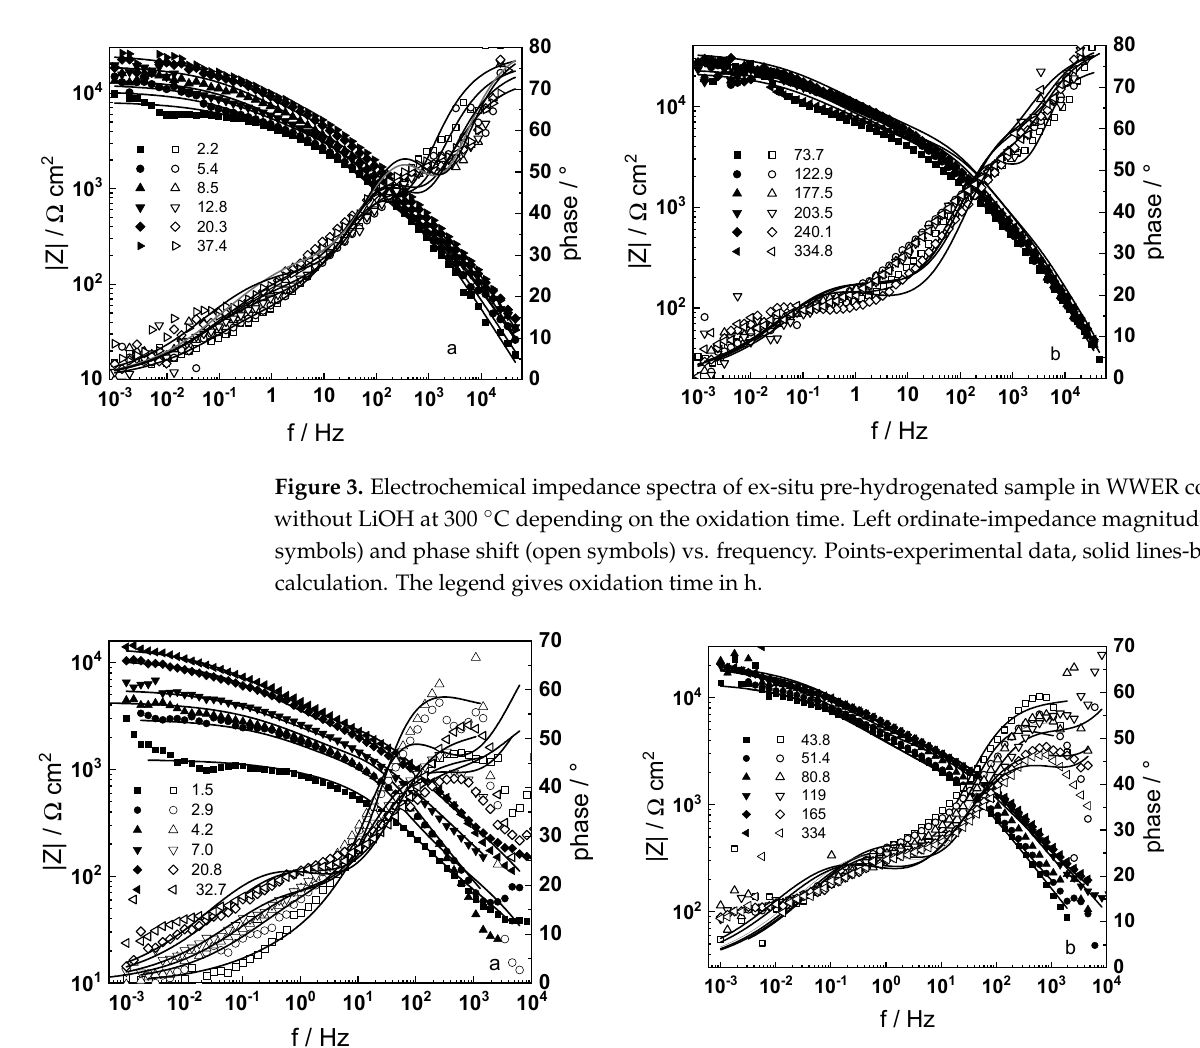
Figure 4. Electrochemical impedance spectra of in-situ pre-hydrogenated sample (galvanostatic mode) in WWER coolant without LiOH at 300 ◦ C depending on the oxidation time. Left ordinate-impedance magnitude (full symbols) and phase shift (open symbols) vs. frequency. Points-experimental data, solid lines-best-fit calculation. The legend gives oxidation time in h.